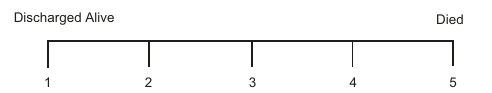
Fig. 9 The ‘ fuzzy ’ prediction scale. Speci fi cally, the predicted labels 1 – 5 (i.e., A – E) on an ordinal scale where the two extremes represent the binary classi fi cation task: 1 = Discharged alive from ICU within the next hour, 5 = Died in ICU within the following